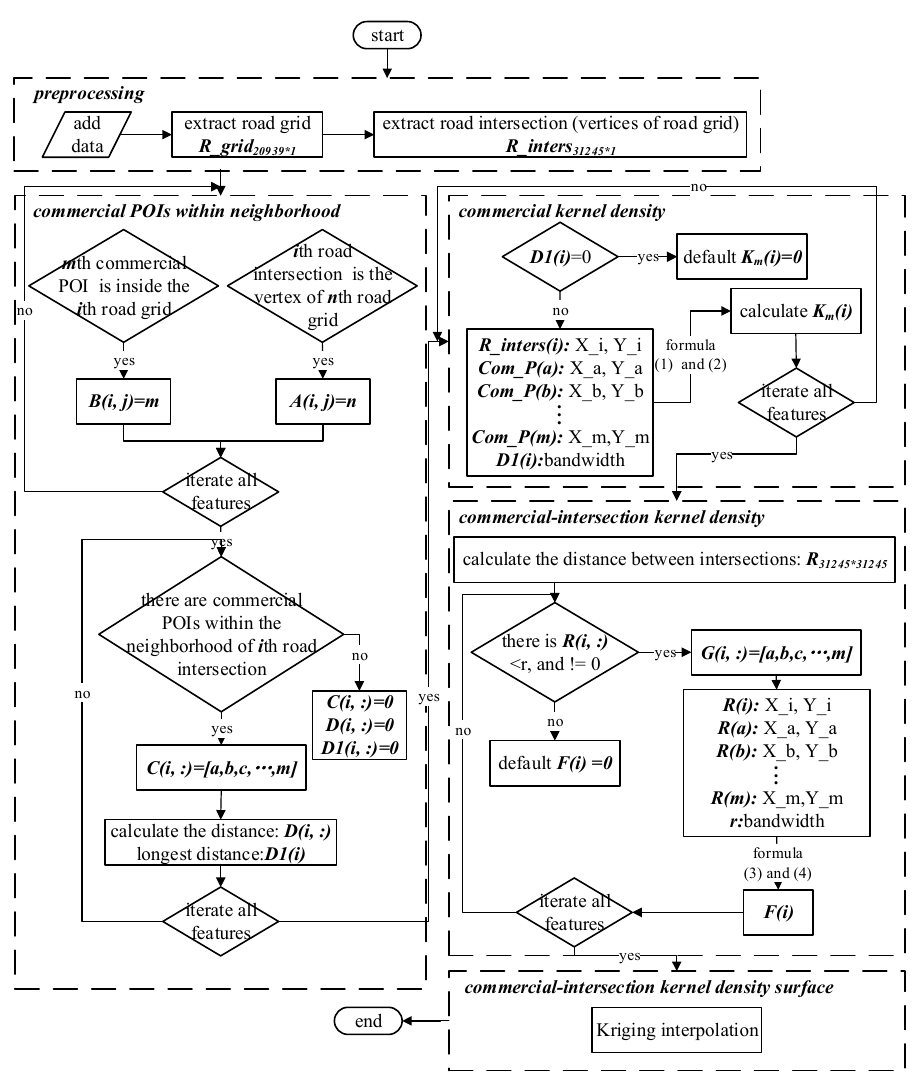
Figure 4. Main steps of the commercial-intersection KDE algorithm.